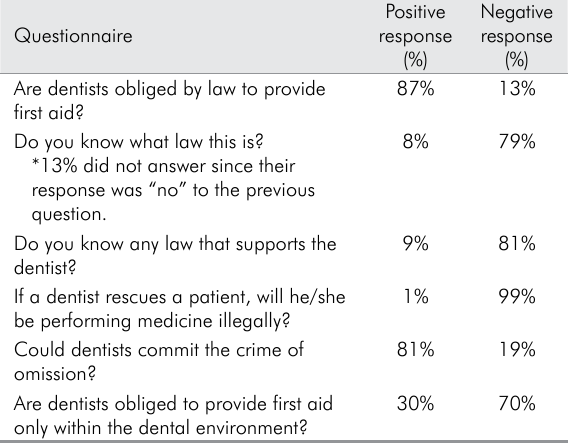
Table 2. Extent of ethical and legal implications of the dentists inter- viewed at the Hospital for Rehabilitation of Craniofacial Anomalies Questionnaire